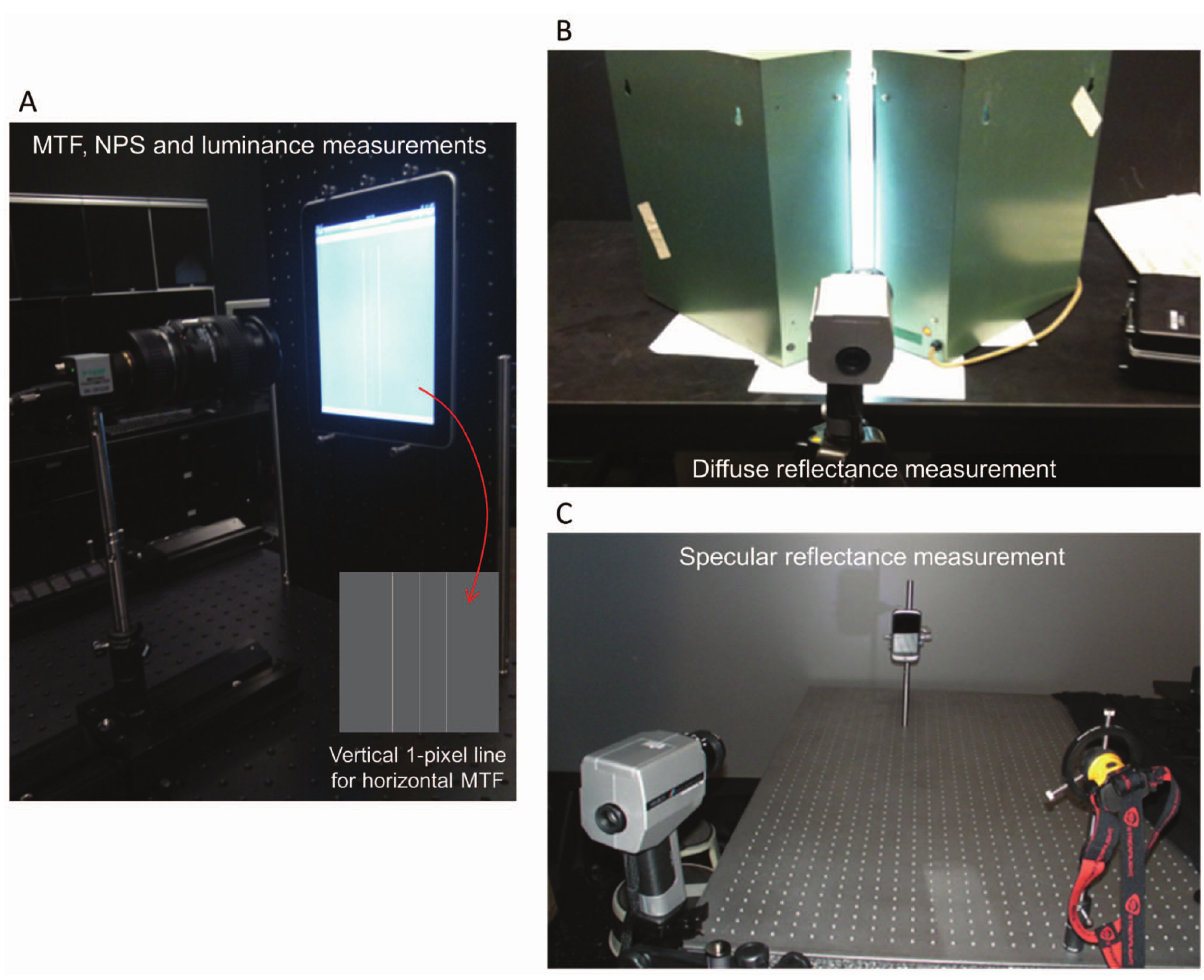
Figure 1. Experiment layouts. A. The layout of the photometric CCD camera capturing the display screen for MTF, NPS and luminance measurements. The center line of the vertical 1-pixel line pattern was used for the horizontal LSF and MTF. B. The layout of the spot photometer measuring the luminance reflected off the display screen through the gap between the fluorescent lights for diffuse reflectance measurement. C. The layout of the spot photometer measuring the luminance reflected off the display using the flash light source for specular reflectance measurement. The photometer and light source were positioned symmetrically 78.7 cm away at 15 u from the normal relative to the screen.